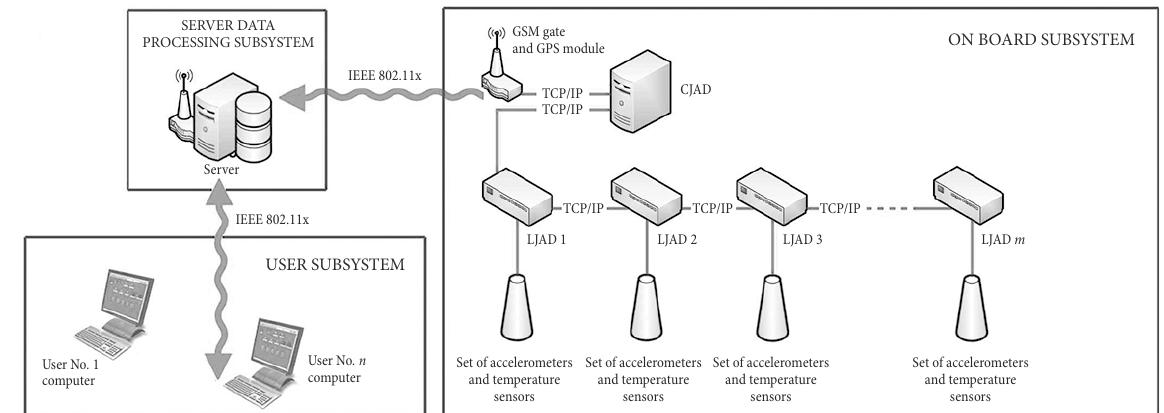
Fig. 3. Scheme of rail vehicle’s and rail track monitoring system